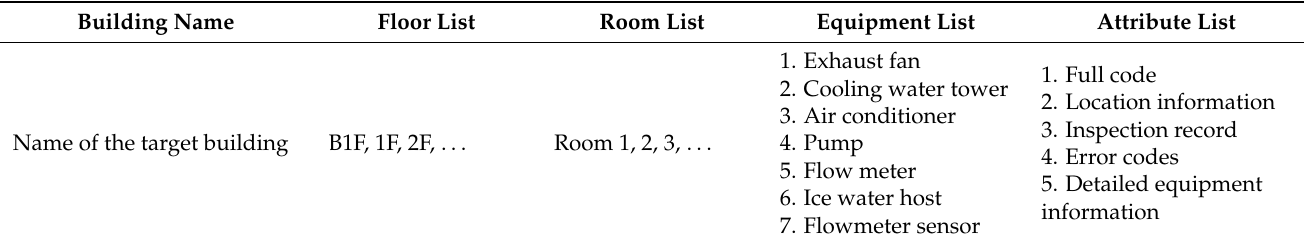
Table 2. Equipment dataset for facility manager.